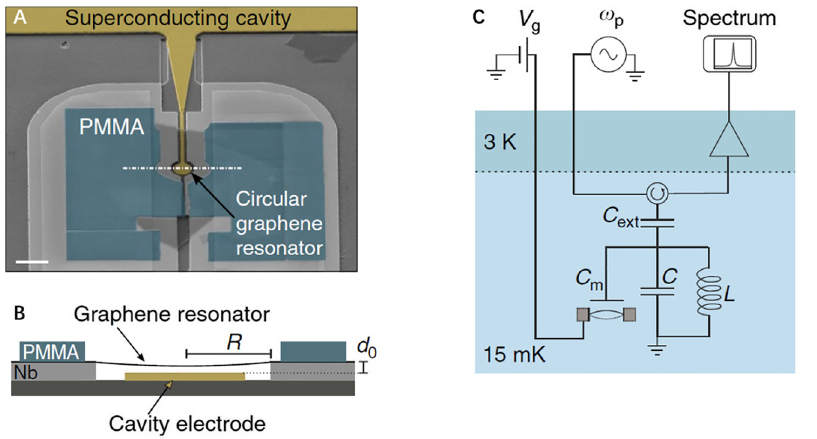
Figure 14: (A) False-color image of multilayer graphene optomechanical devices. (B) Cross-sectional illustration of the graphene resonator along the white dashed dotted line in (A). (C) Schematic of the detection circuit. The superconducting cavity couples with the graphene mechanical resonator through the capacitance